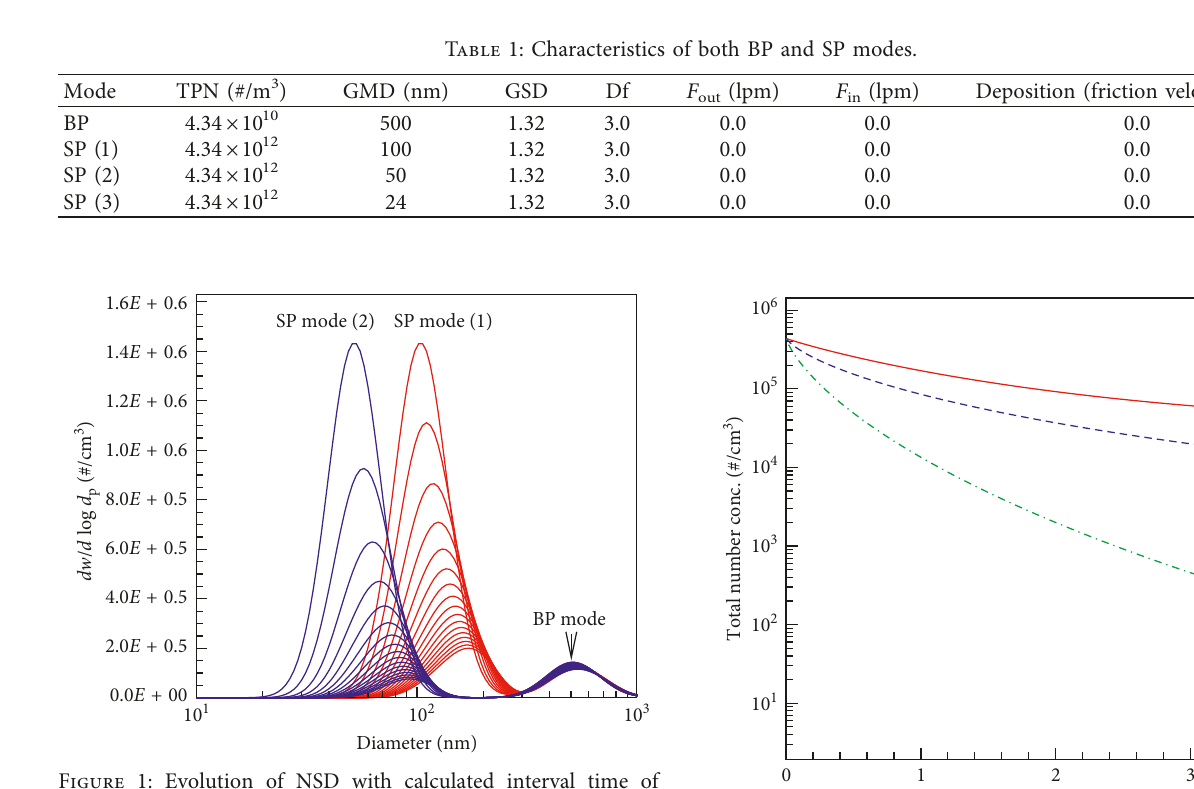
Figure 1: Evolution of NSD with calculated interval time of 11.25min. Red lines represent particle size distribution of aerosols composed by the BP mode and SP mode (1), and blue lines rep- resent particle size distribution of aerosols composed by the BP mode and SP mode (2).